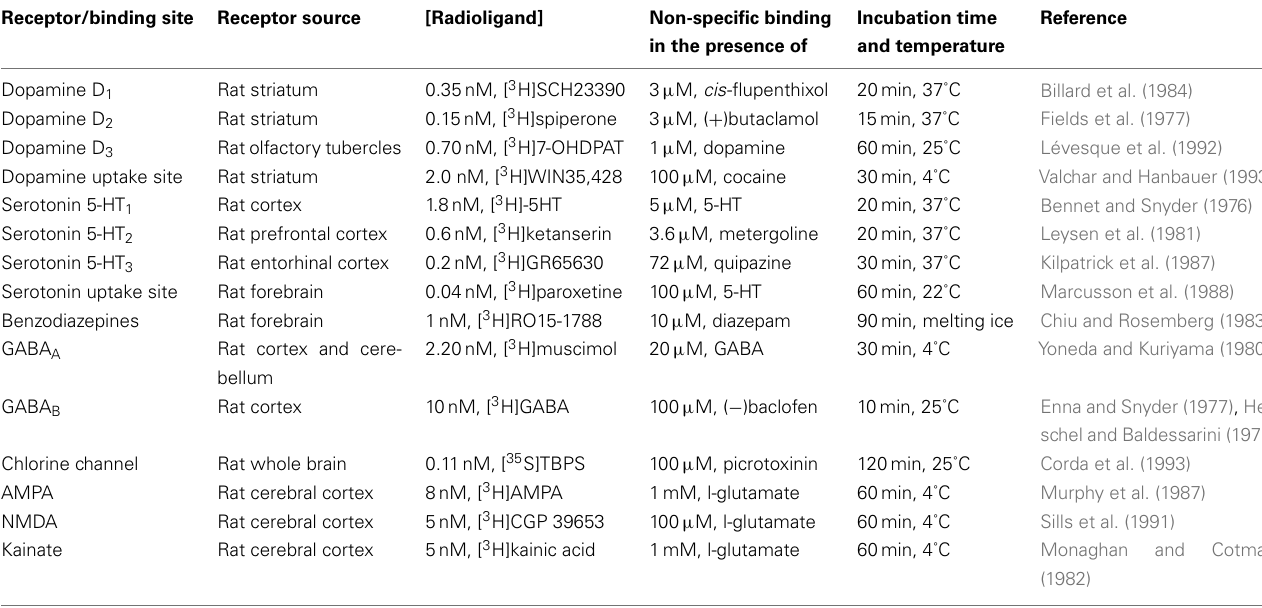
Table 1 |Assay conditions for radioligand binding